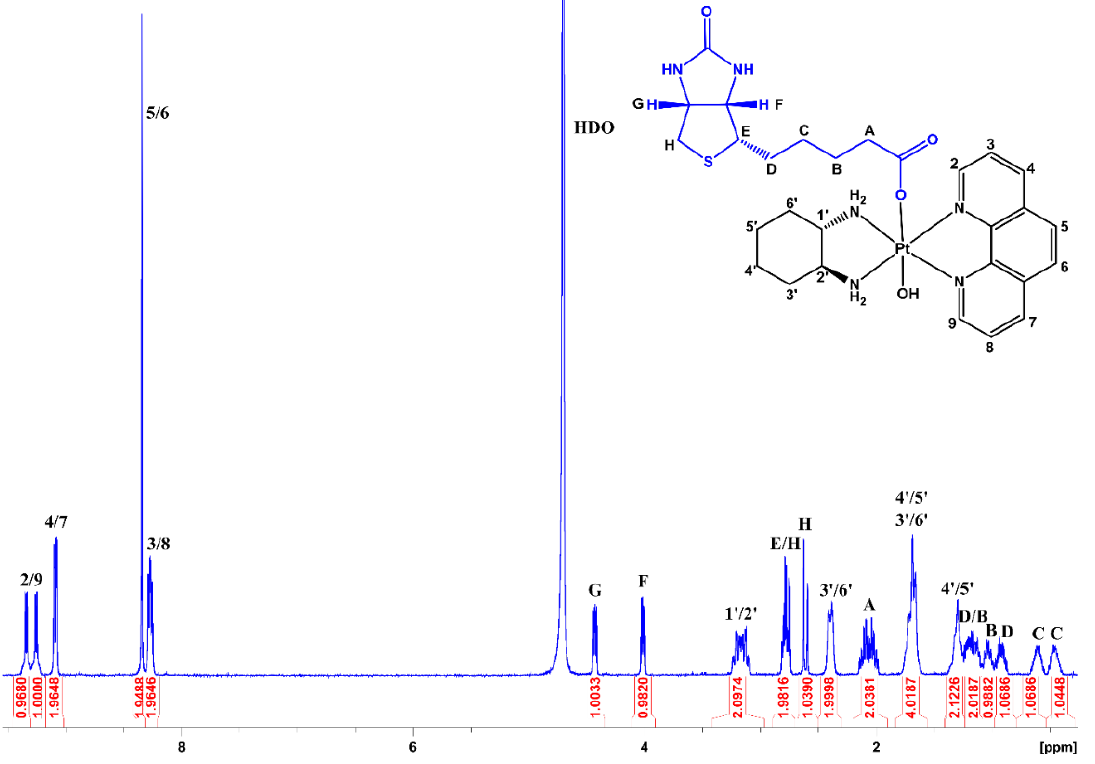
Figure 4. The 1 H NMR spectrum of [Pt(Phen)(SSDACH)(Biotin)(OH)](NO 3 ) 2 ( 1 ) in D 2 O at 298 K. Insert: The chemical structure of 1 with assigned numbering/lettering.